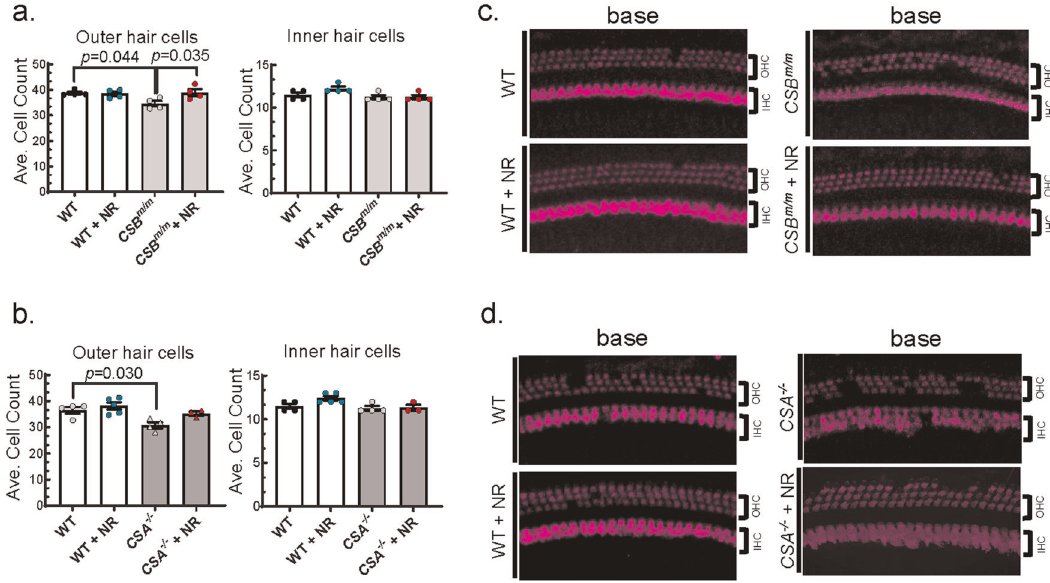
Fig. 4 Outer hair cells are reduced in CSA − / − and CSB m/m mice, and short-term NR supplementation rescues outer hair cell loss in CSB m/m mice. a Summary data for the average number of outer (left) and inner (right) hair cells per 100 μ m in the basal region of the cochlea in WT or CSB m/m mice with and without NR treatment (12 mM in drinking water for 10 days) at 6.5 weeks of age. The decreased number of outer hair cells observed in CSB m/m mice is prevented by NR treatment. In contrast, no changes in the number of inner hair cells were observed between conditions. N = 4; mean ± S.E.; two-way ANOVA with Tukey ’ s post-hoc test was used to determine signi fi cant difference. b Representative images of outer and inner hair cells in the cochlear base region of CSB m/m and WT mice following NR treatment as described in a . Myo7a staining is used to identify hair cells. c Outer hair cells were reduced in base region in CSA − / − mice ( CSA − / − ( N = 4); CSA − / − + NR ( N = 3); WT ( N = 4); WT + NR ( N = 5)). Mean ± S.E.; two-way ANOVA with Tukey ’ s post-hoc test was used to determine signi fi cant difference. d Representative images of base outer and inner hair cells of CSA − / − and WT mice following NR treatment as described in c . Myo7a staining is used to identify hair